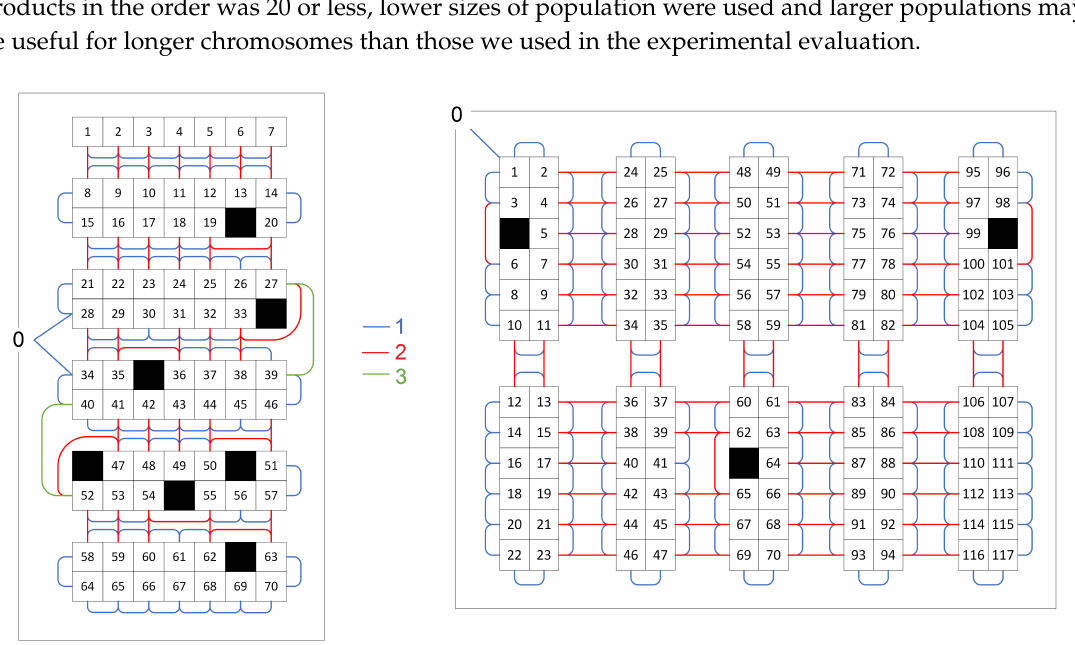
Figure 6. Samples warehouse structures (floor plans) of the warehouses w5 and w1 used in the experiments. Each numbered cell represents one product location. Blue lines show the distance of 1 unit, red lines of 2 units and green lines of 3